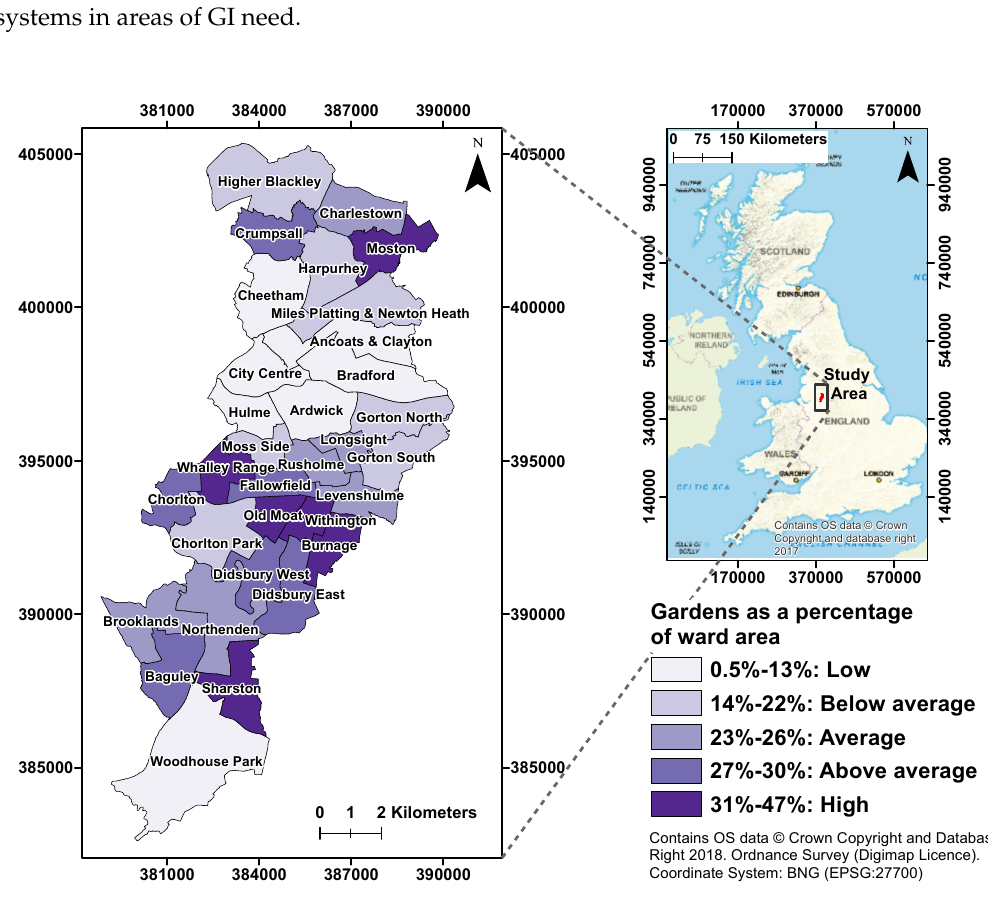
Figure 1. Gardens as a percentage of ward area (groups classified by standard